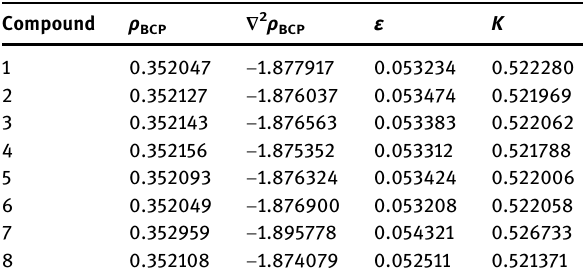
Table 4: QTAIM analysis of N – H bonds within the structure of azoles 1 – 8 ( B3LYP/6 - 311 ++ G ( 2d,3p ) //B3LYP - 631G ( d,p ) ; gaseous phase ) ; electron density at the BCP ( ρ BCP /a.u. ) , Laplacian of electron density ( ∇ 2 ρ BCP /a.u. ) , bond ellipticity ( ε ) , the